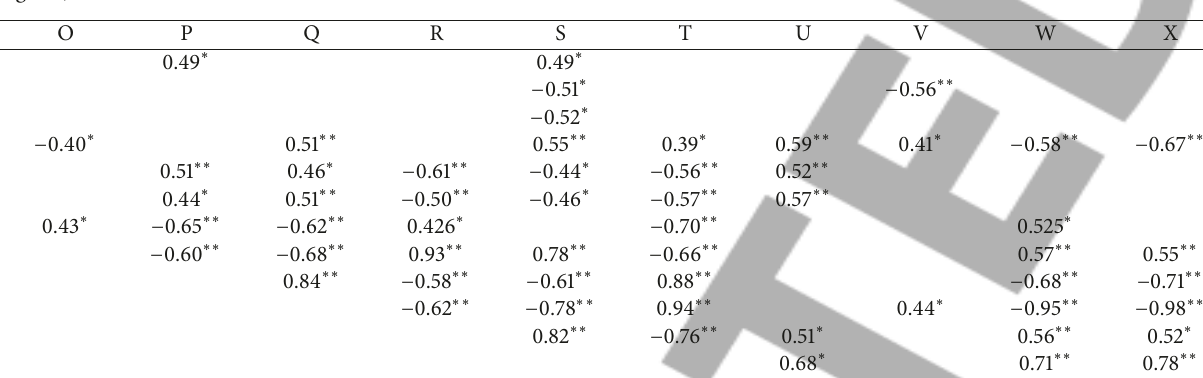
Table 1: Cross-correlation matrix showing na¨ıve multiple correlations of Apoidea (bee) variables with environmental, local, and landscape variables ( different levels of significance ofSpearman rank of correlation coefficients: ∗ P < 0.05 ; ∗∗ P < 0.001; otherwise not significant when no value given )